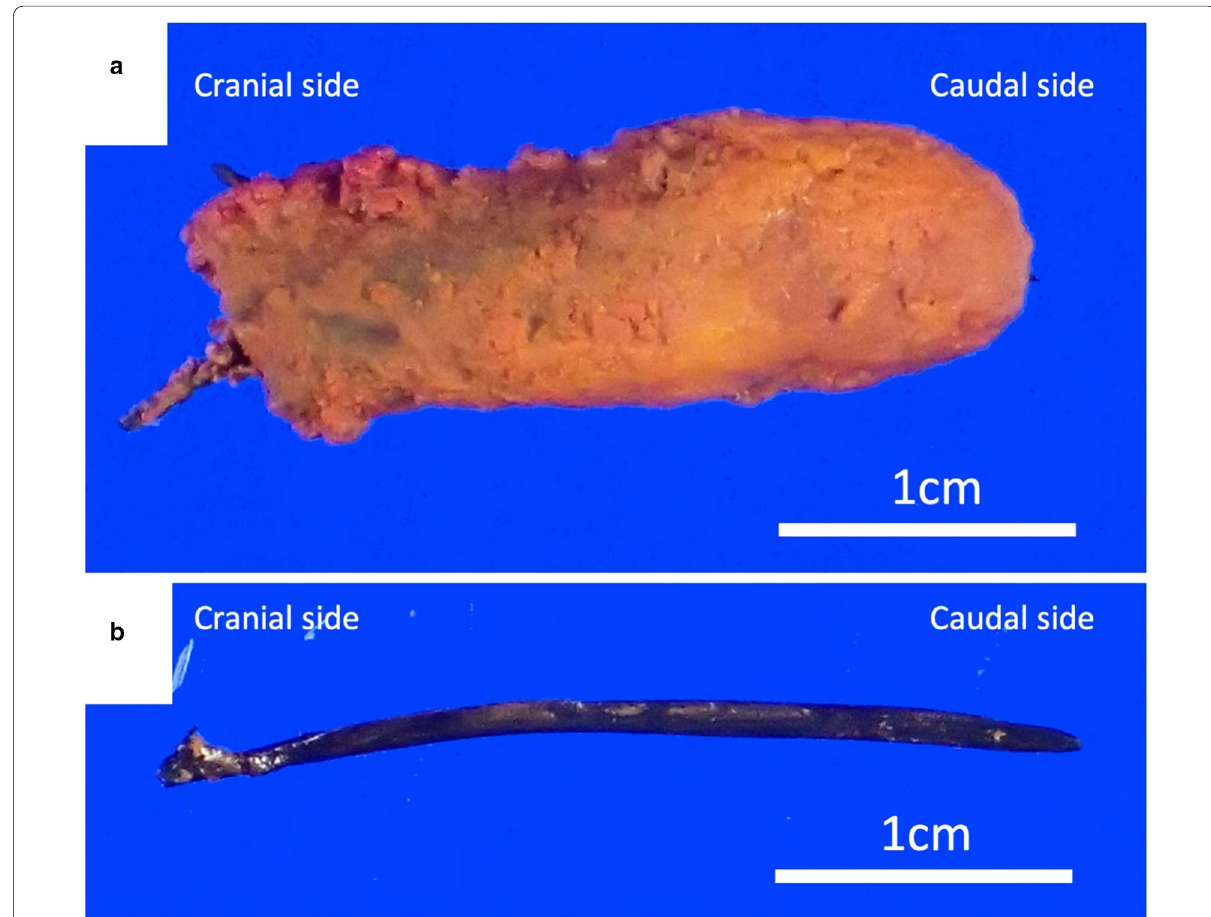
Fig. 3 The extracted common bile duct (CBD) stone. Insoluble calcium salts aggregated and formed stones around the fish bone that acted as a nidus ( a ). The fish bone was approximately 3 cm in length ( b